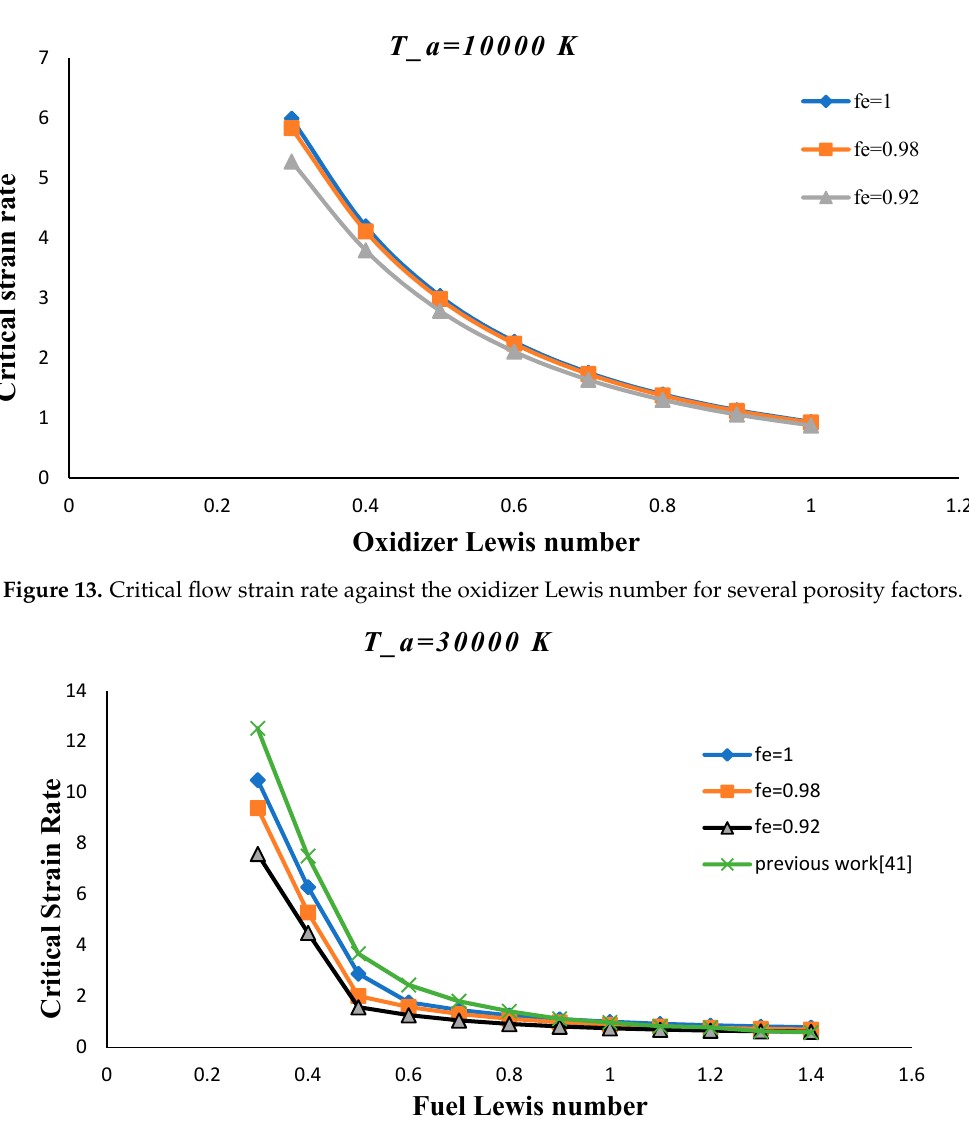
Energies 2018 , 11 , x FOR PEER REVIEW Figure 14. Critical flow strain rate against the fuel Lewis number for different porosity factors.